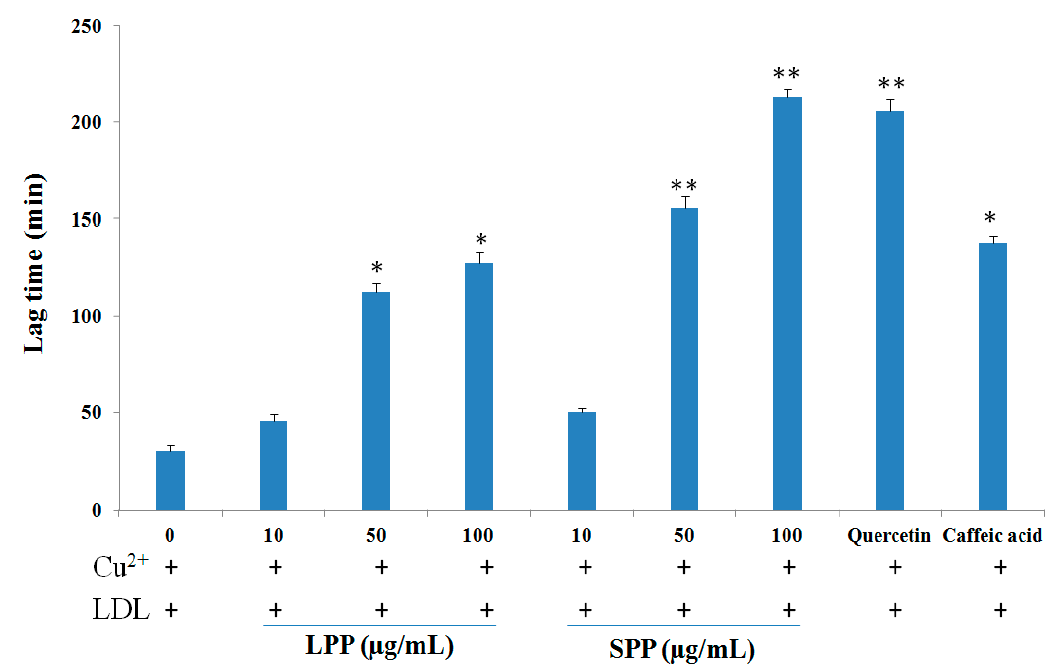
Figure 1. Effects of LPP and SPP on kinetic of Cu 2+ mediated LDL oxidation. Data were expressed as mean S.D. values for n = 3. * p < 0.01, ** p < 0.05 compared to negative control. Quercetin (5 µM) and caffeic acid (5 µM) were used as positive controls.